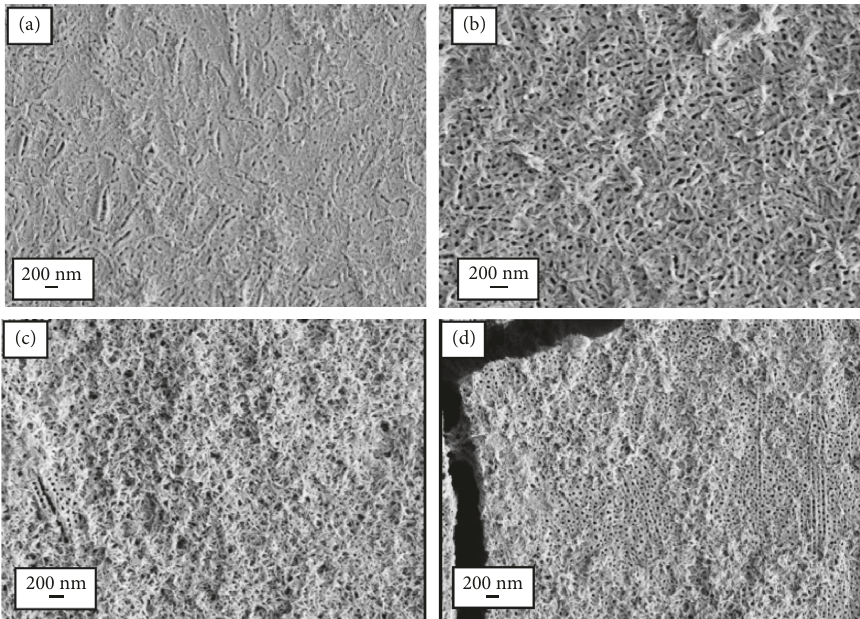
Figure 2: The NTdisk surface following immersion in a suspension of HAp. The NTdisk surface following precipitation of (a, b) HAp and (c, d) Ag-doped HAp layer at two respective